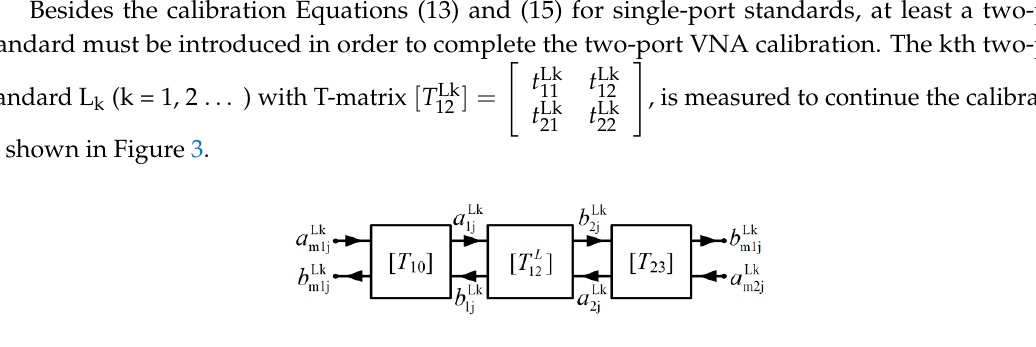
Figure 3. Two-port calibration.